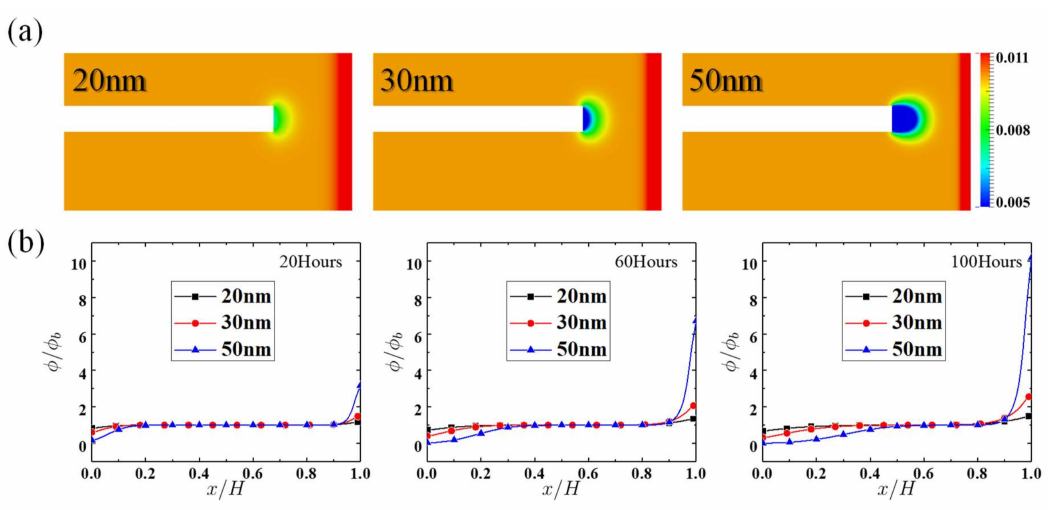
Figure 4. ( a ) Nanoparticle concentration fields with different sizes of nanoparticles after 100 h of simulation. ( b ) Nanoparticle profiles along the X-direction with different sizes of nanoparticles at radial position R = 1.167 and different